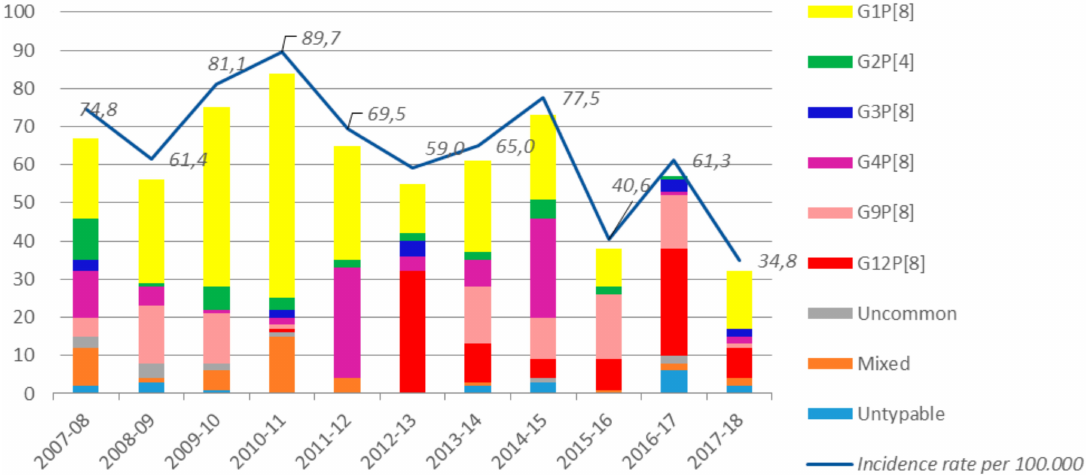
Figure 1. Absolute frequencies of RV genotypes detected (see legend) and hospitalization rate (including one-day care) for RVAGE per 100,000 inhabitants stratified by surveillance